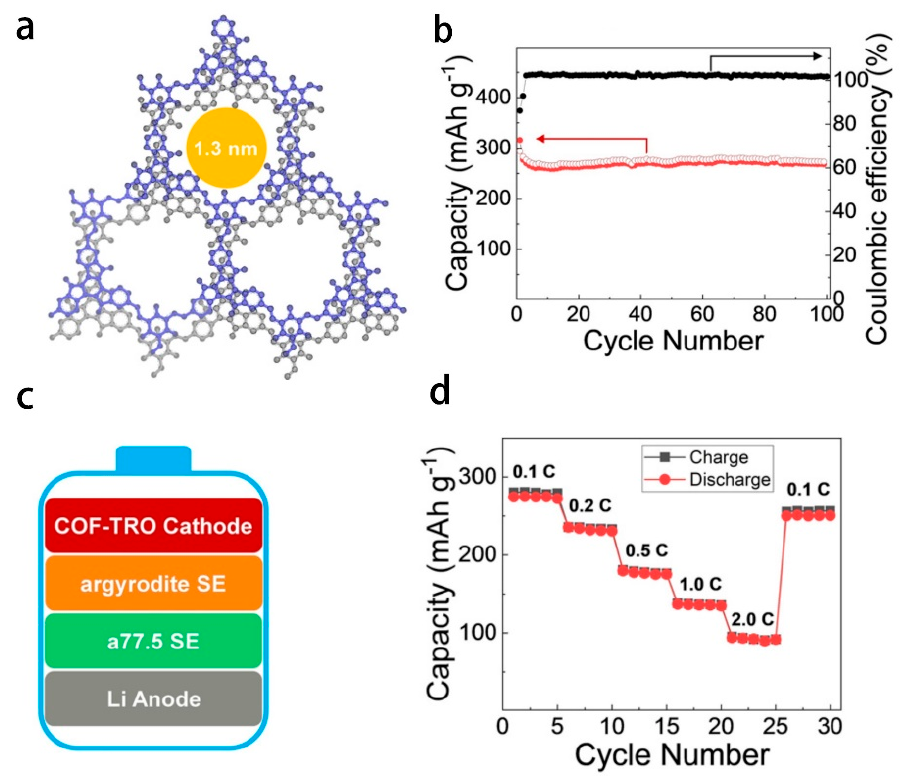
Figure 5. ( a ) Characterization of COF − TRO. ( b ) Cycling stability of COF − TRO at a current rate of 0.1 C and corresponding Coulombic efficiencies. ( c ) All − solid − state battery configuration. ( d ) Rate study of COF − TRO. Adapted with permission from ref. [162]. Copyright 2020 John Wiley and